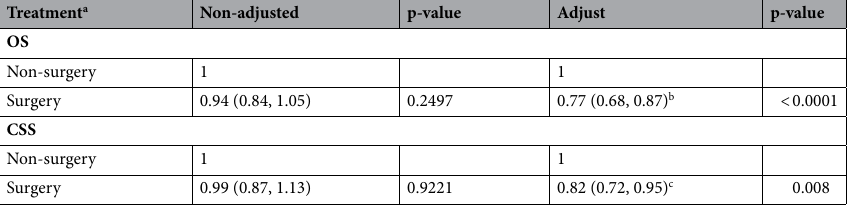
Table4. Multivariable Analysis of OS and CSS in Non-surgery group and surgery group after matching. OS overall survival, CSS cancer specific survival. a After PSM with 1:1 ratio, there were both 1434 patients in the matched surgery and non-surgery groups, respectively. b Adjusted for age, year of diagnosis, Ann Arbor Stage, histologic and tumor site. c Adjusted for age, gender, marital status, year of diagnosis, Ann Arbor Stage, histologic, tumor site and